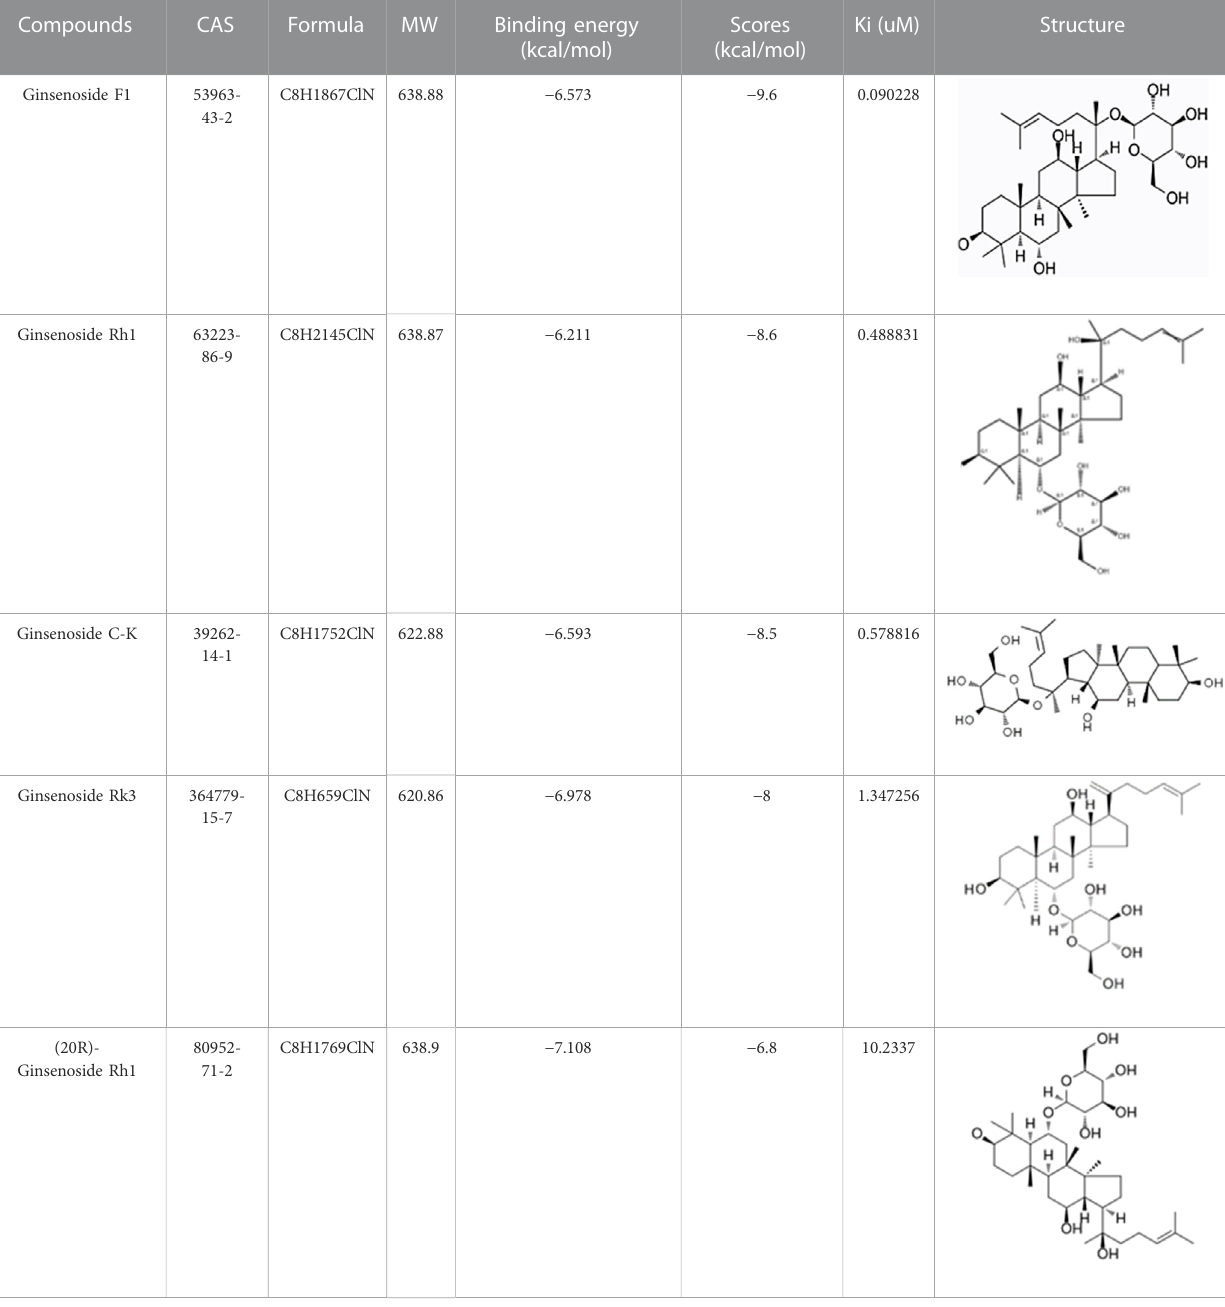
TABLE 2 Five candidate ginsenosides as TMPRSS2 inhibitors.